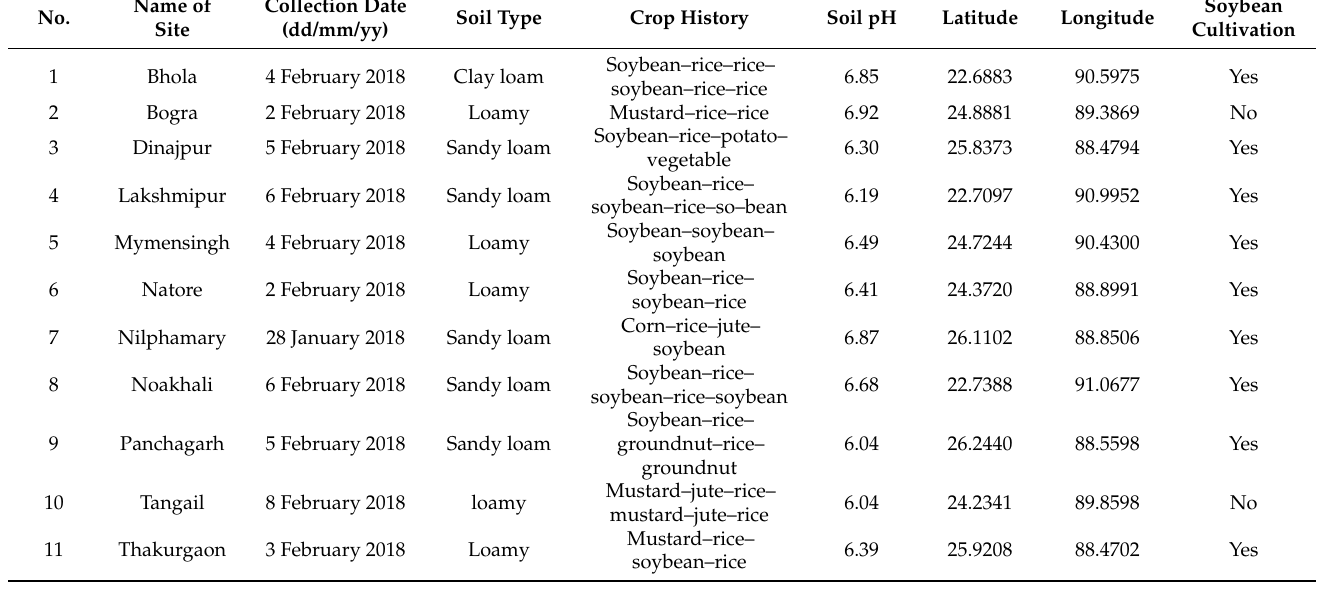
Table 1. Information of soil sample collection sites.